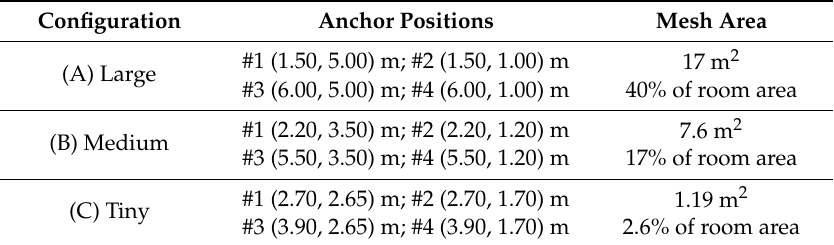
Figure 9. ( a ) Bidimensional map of the experimental test site, ( b ) with the superimpose of the three constellations adopted in this work, and ( c ) the corresponding picture. Table 1. Anchor–mesh configurations.